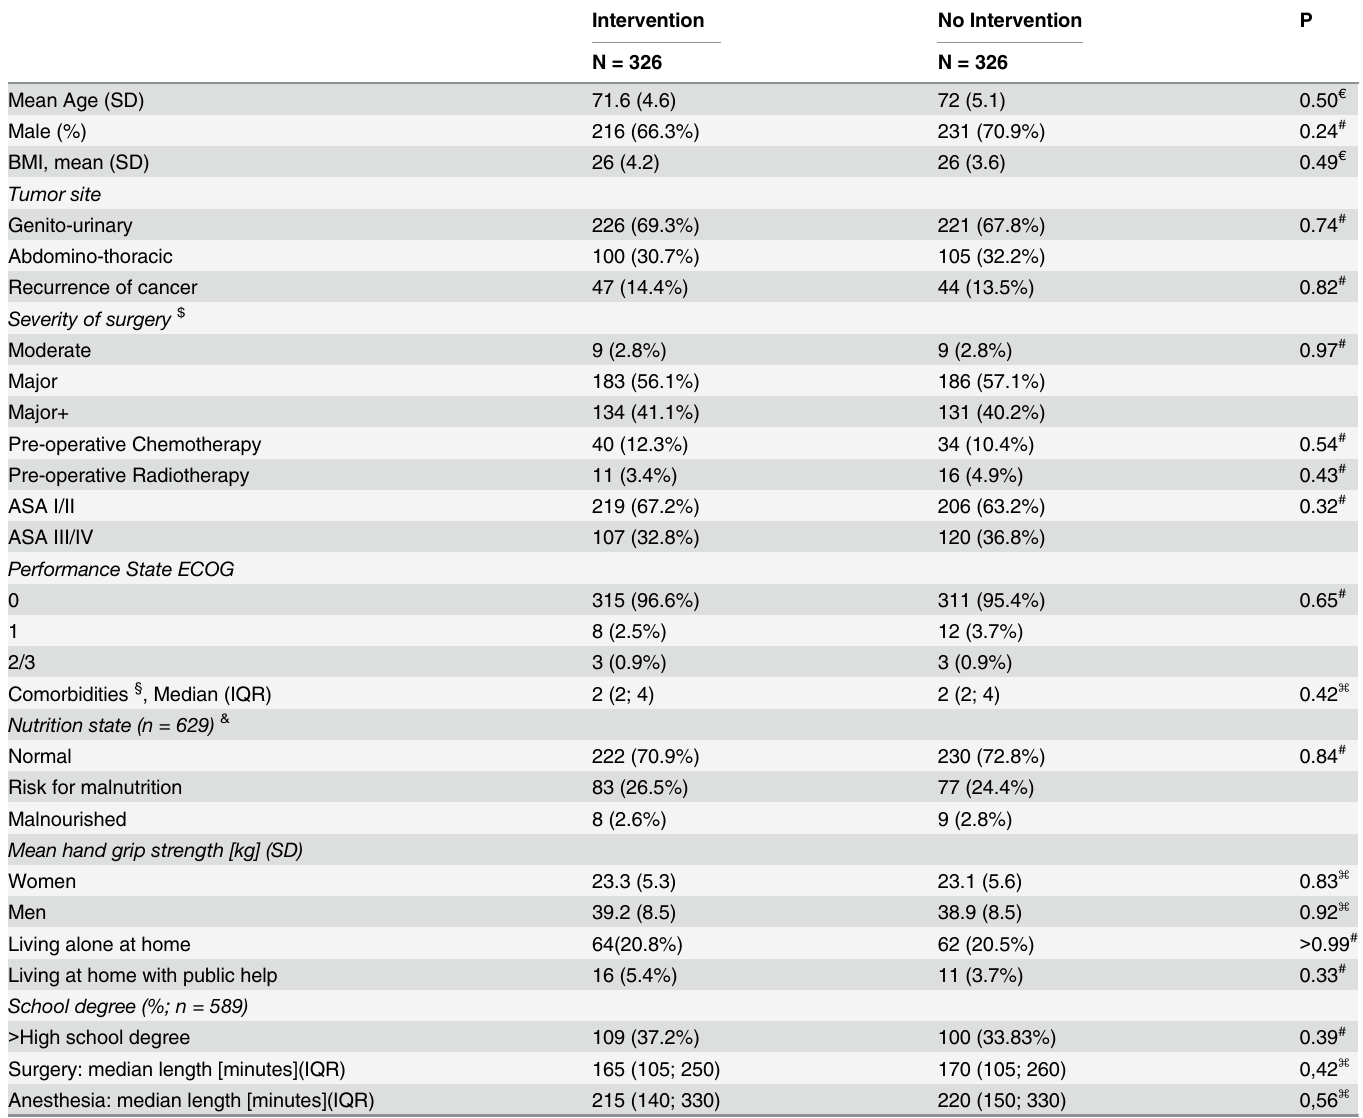
Table 1. Demographic and clinical baseline characteristics of the study population.